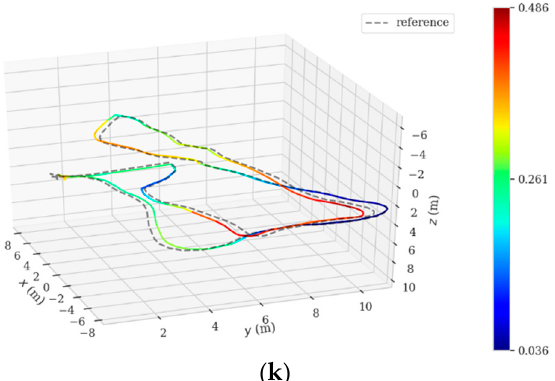
Figure 7. VIO Performances when dealing with sequences at different difficulty levels. ( a ) V1_01_ easy